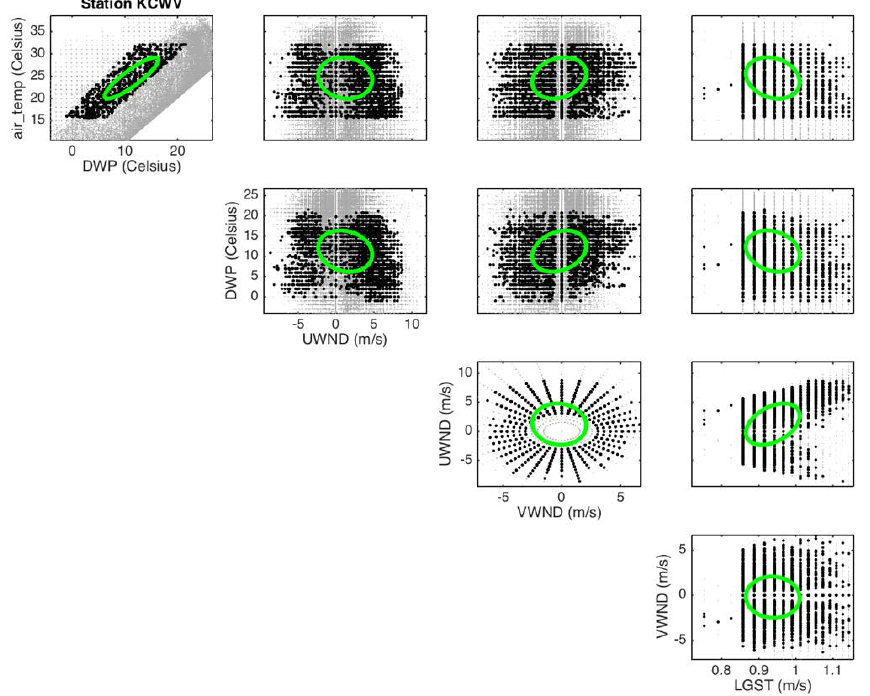
Figure A6. As in Figure 4 but for station KCVW.